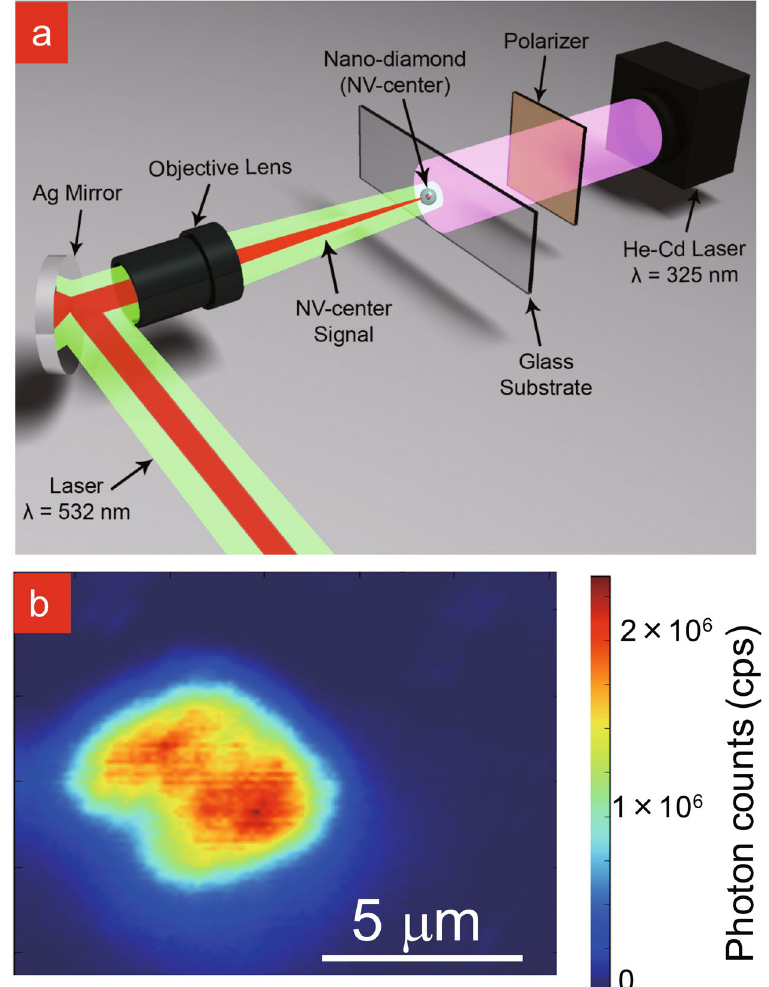
Figure 3. ( a ) Schematic view of the experimental setup. ( b ) Typical 2D fluorescence mapping of NV nanodiamonds (500